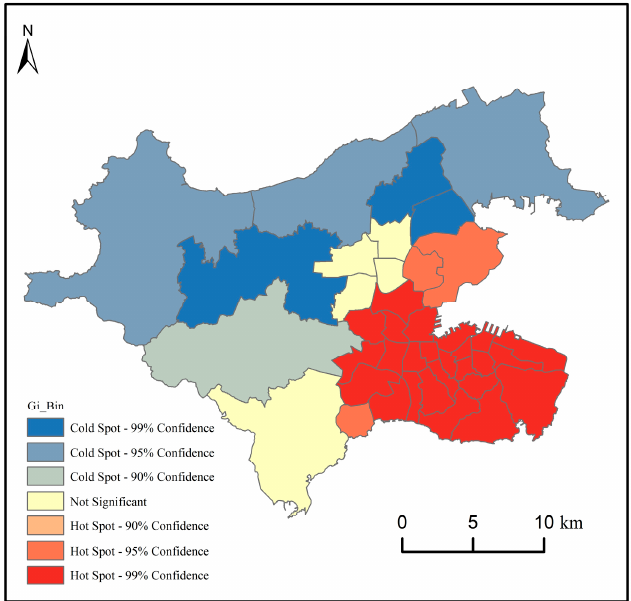
Figure 5. Spatial distribution of vitality of urban human settlements, cold and hot spots.